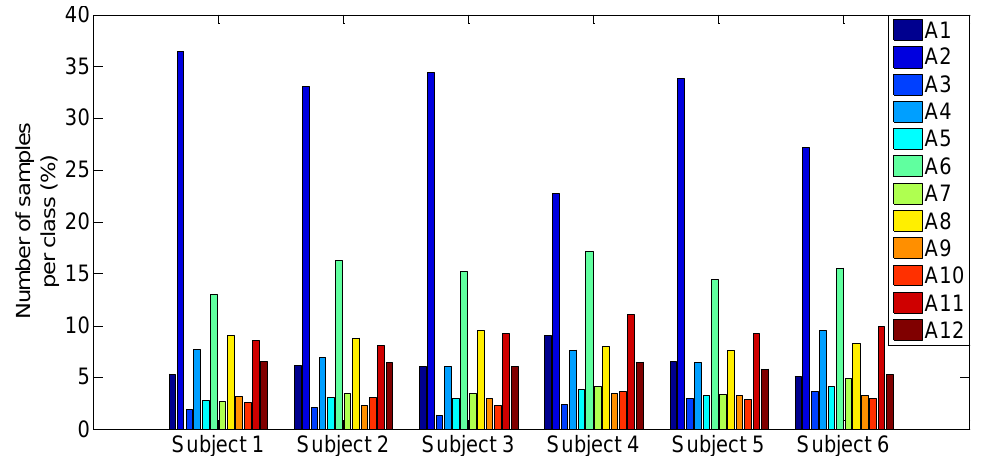
Figure 5. Representation of the number of samples in each class for each sequence.